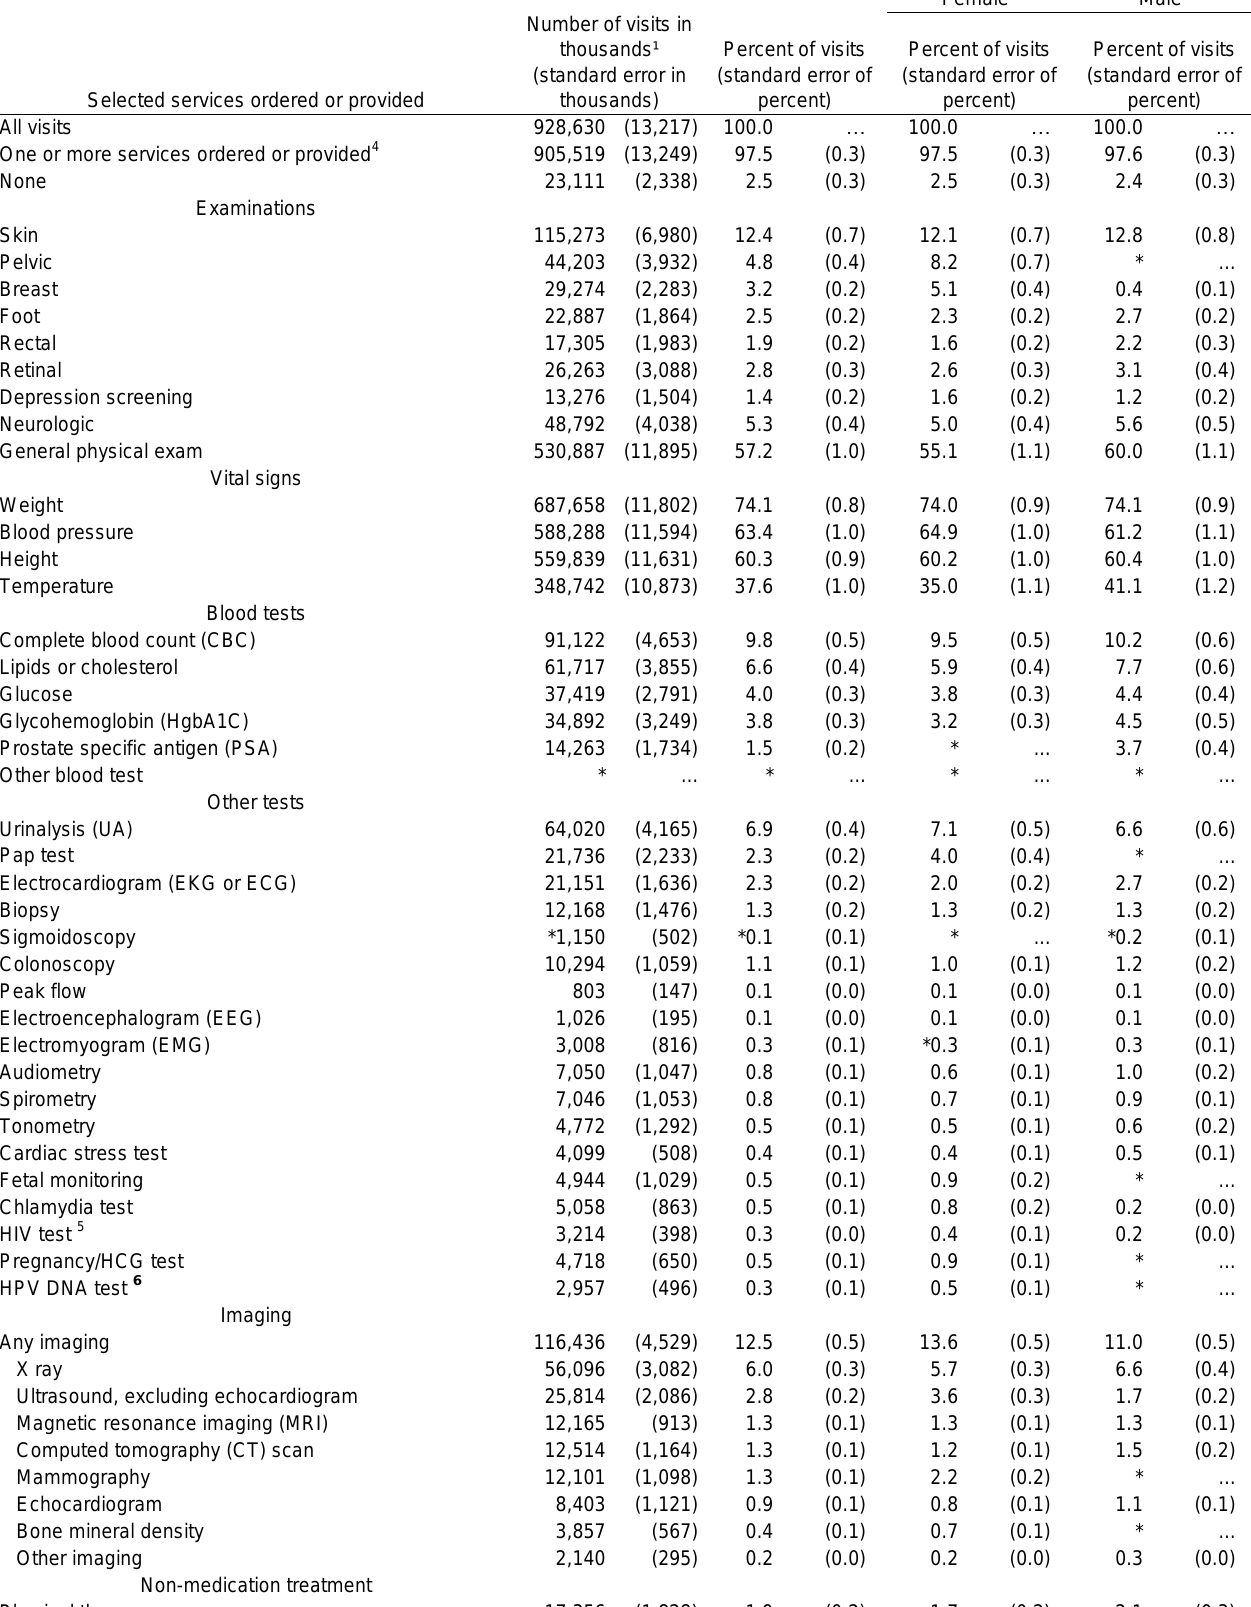
Table 21. Selected services ordered or provided at office visits. by patient sex: United States, 2012